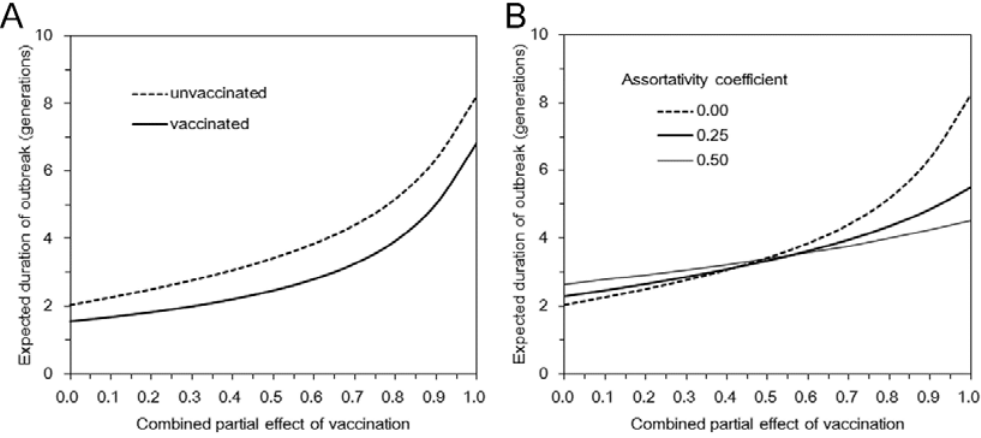
Figure 3. Expected duration of minor outbreak under vaccination. In both panels, the horizontal axis represents the product α ( A ) Expected duration of outbreak given a single infected individual is compared by vaccination history of the index case. Random mixing assumption was adopted. ( B ) Expected duration of outbreak given a single unvaccinated index case with different values of assortativity